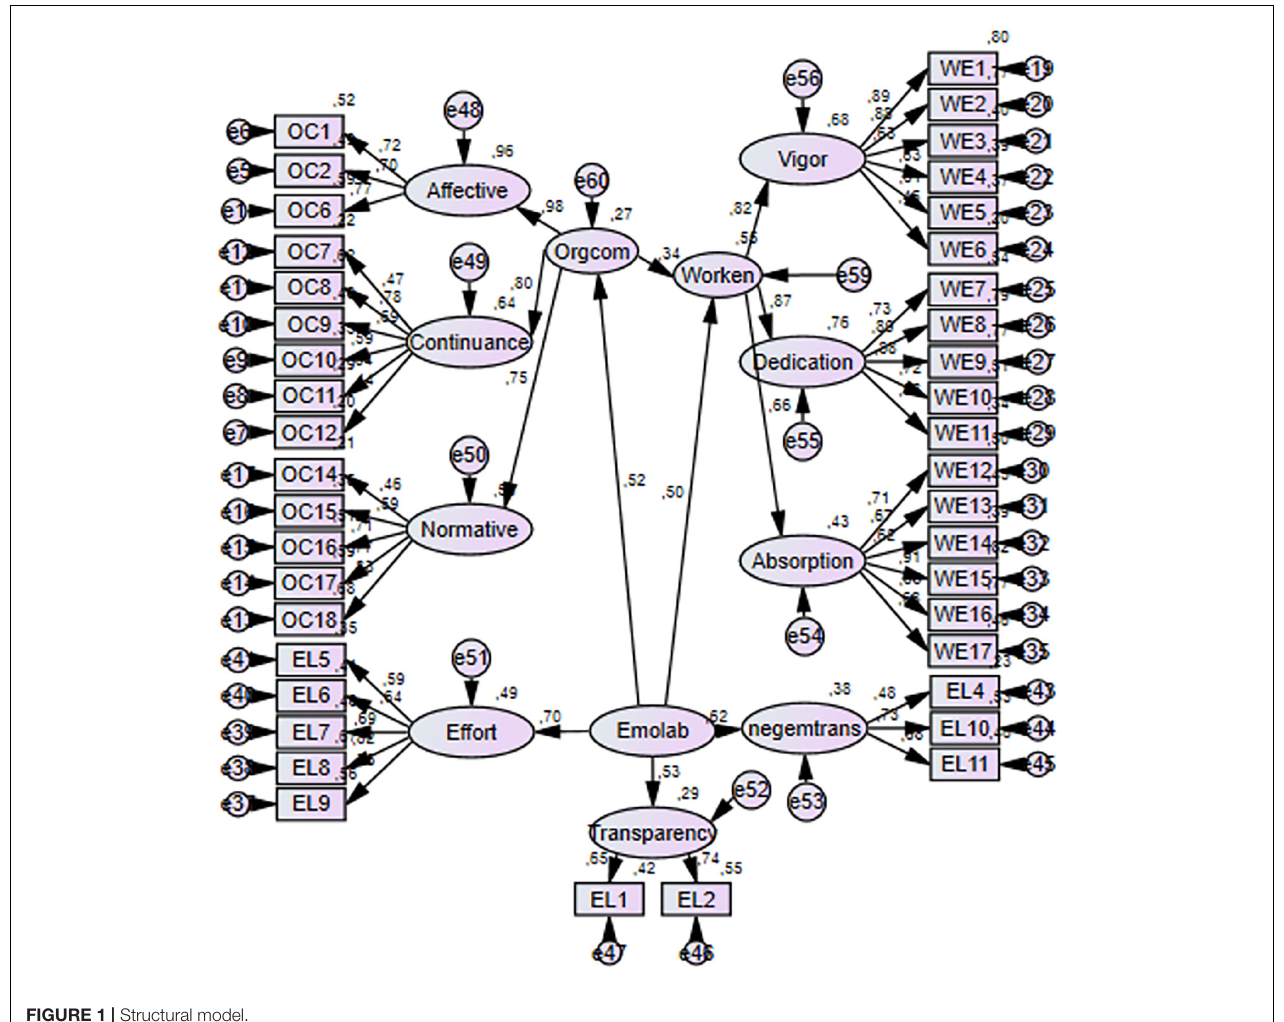
FIGURE 1 | Structural model.